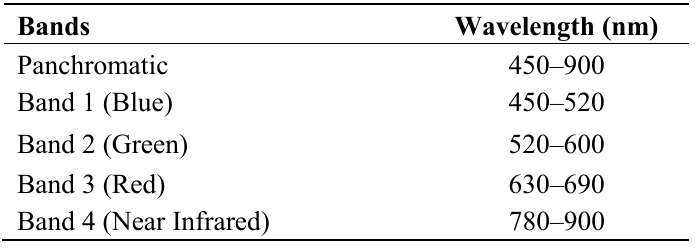
Table 3. Spectral resolution of the Quickbird image.